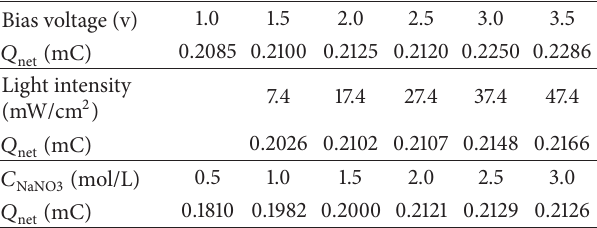
Table 1: The relationship between 𝑄 PEC